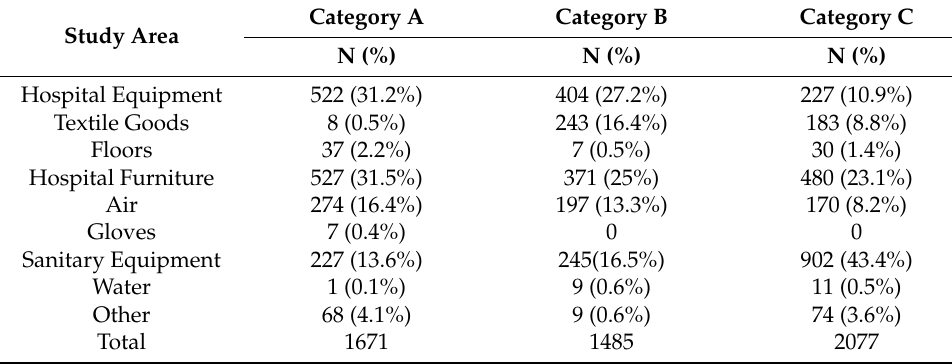
Table 2. Distribution of the bacteriological purity categories of the samples 1